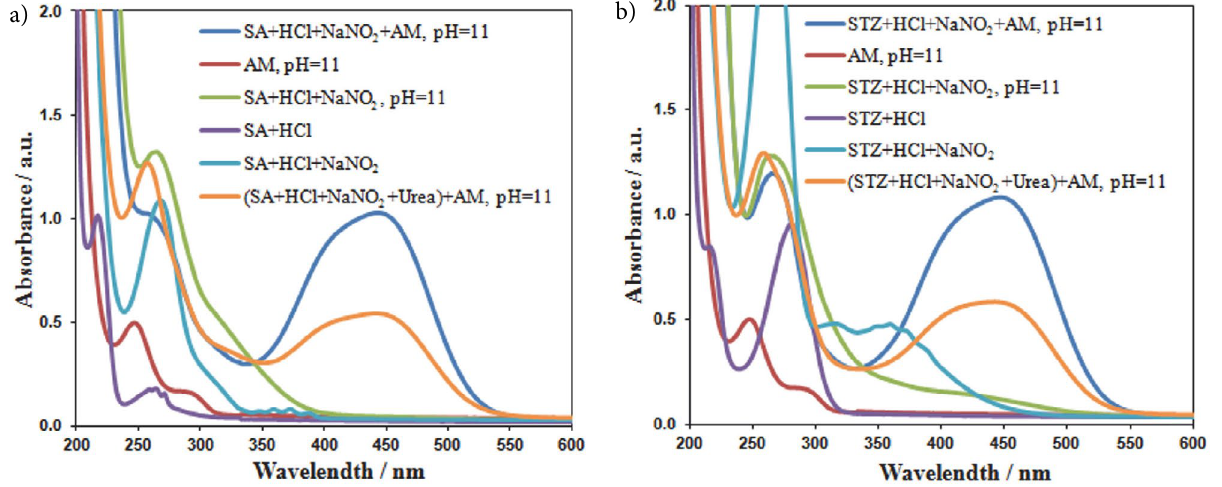
Fig. 1. Absorption spectra of aqueous solutions of AM interaction products with a) SA and b) STZ diazonium salt. C SA = 1.0 . 10 –4 M, C STZ = 1.0 . 10 –4 M, C